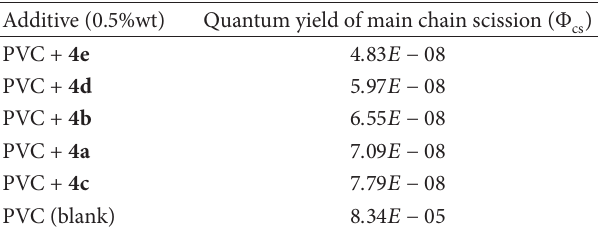
Scheme 5: A suggested mechanism of photostabilization of PVC by 4e through interaction between the polymer chains and Schiff base compounds, leading to more effective energy transfer. ) for chain scission for PVC films Table 1: Quantum yield ( Φ cs (30 𝜇 m) with and without additive (0.5%wt) after 250 h irradiation